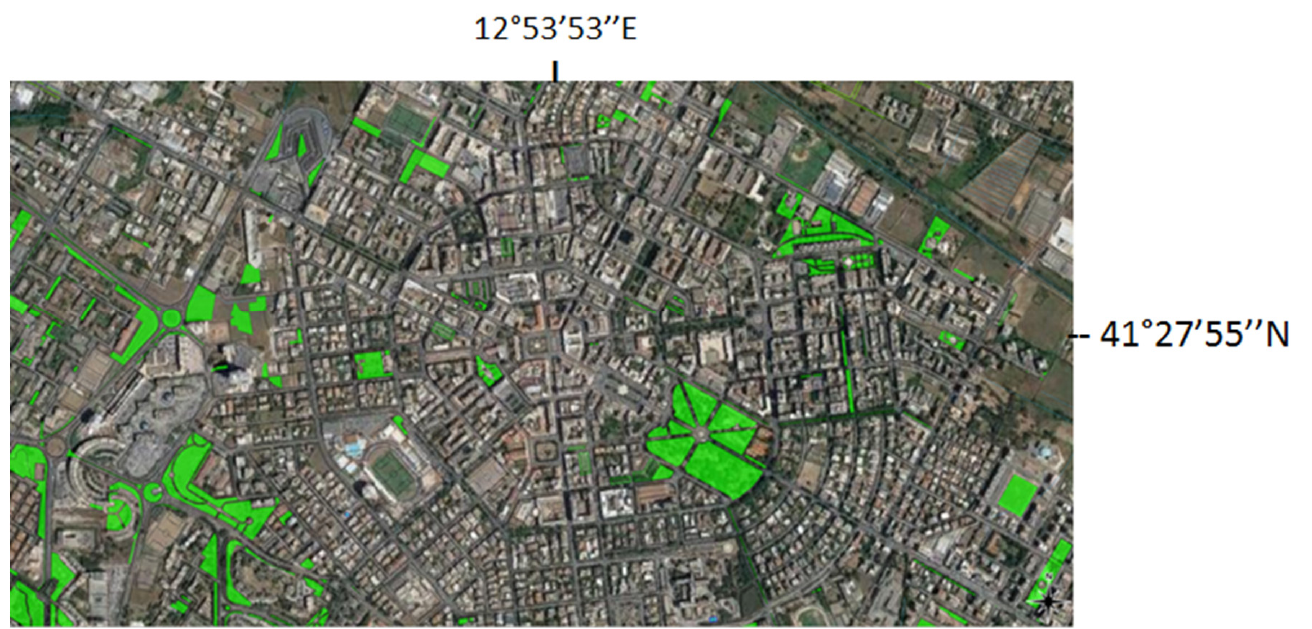
Figure 5. Example of cartographic output of Macro Area A. The present map shows a suburban area of the city and extensive parks subject to regular green maintenance.